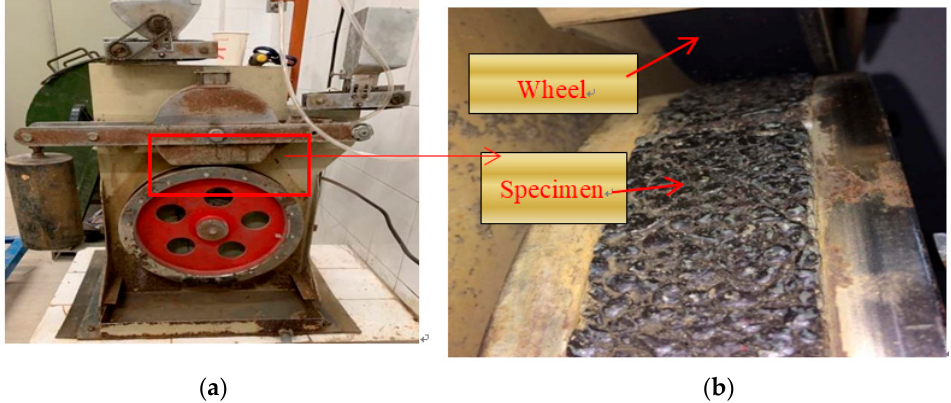
Figure 6. Wear test system: (a) coarse aggregate polishing machine; (b) ultra-thin wearing course specimen.